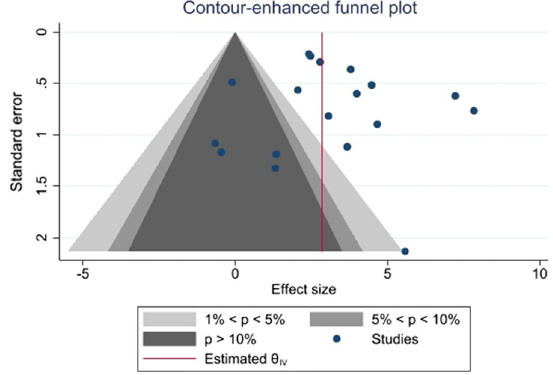
Fig. 3 Contour‑enhanced funnel plot for relative flow‑mediated